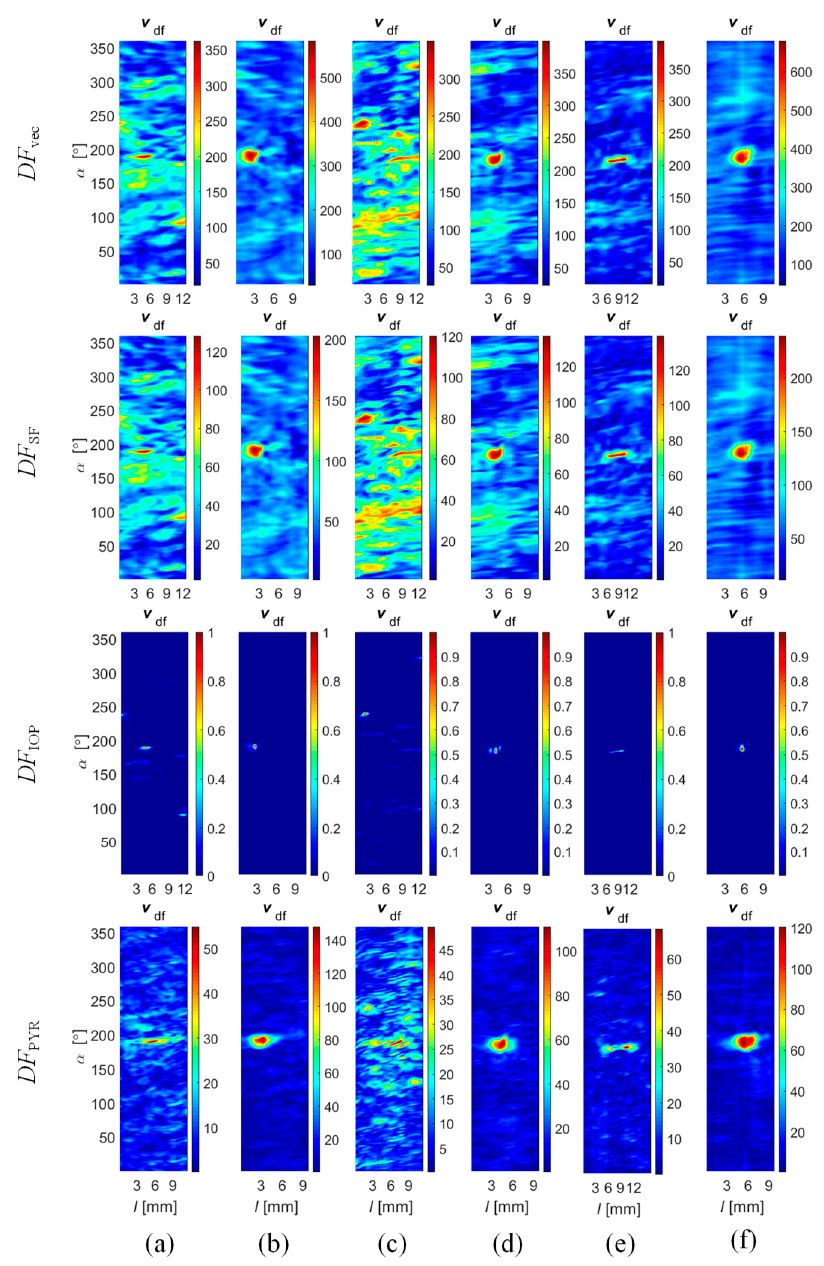
Figure 15. Results of Stage II ( v ndf ) of data fusion obtained for successive defects: 1 mm depth axial d 1 ( a ) and circumferential d 2 ( b ); 0.5 mm depth axial d 3 ( c ) and circumferential d 4 ( d ); and 2 mm depth axial d 5 ( e ) and circumferential d 6 ( f ).